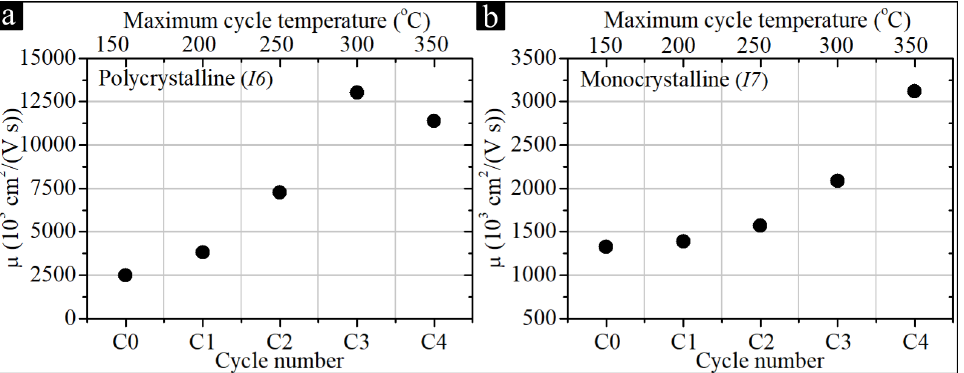
Figure 4. Summary of the final parameters at RT after each successive cycle of the temperature treatment procedure of structures I6 ( a ) and I7 ( b